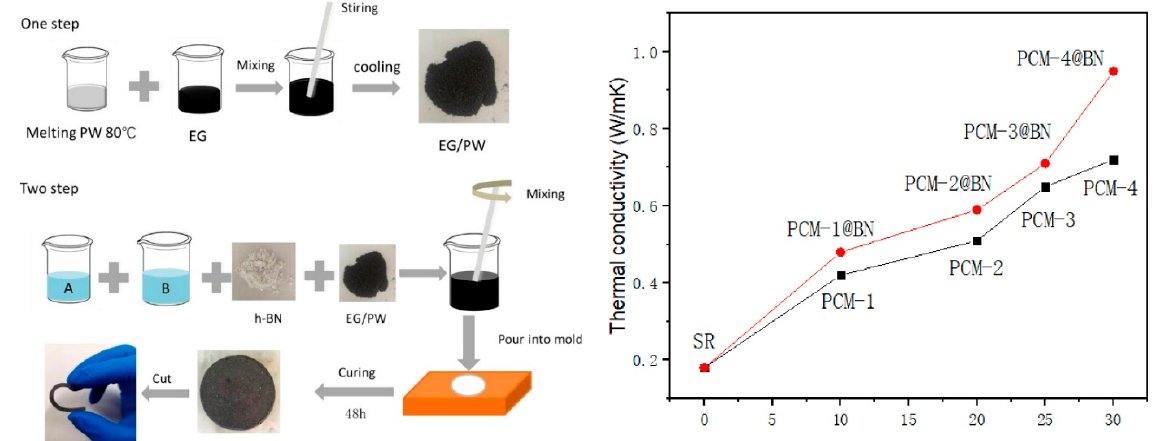
Figure 6. ( Left ): The synthesis process of the composite PCM [43]; ( Right ): Thermal conductivity of the composite PCM as a function of EG/PW ratio. Reproduced with permission from Elsevier.